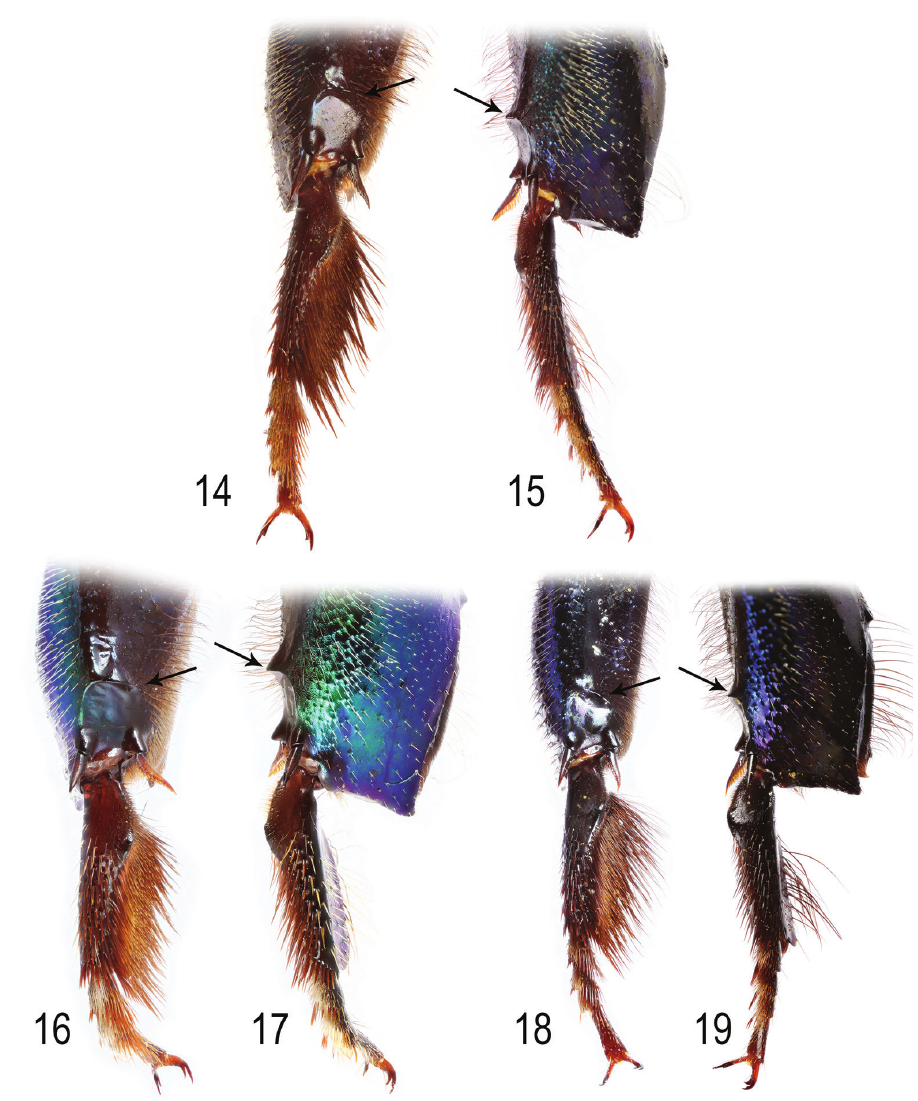
Figures 14–19. Detail of the subapical projection (indicated by an arrow) above the spurs of the male metatibia in anterior ( 14 , 16 , 18 ) and lateral views ( 15, 17, 19 ). 14, 15 E. barthelli (paratype. Mex- ico: Jalisco, Ajijic, KUNHM-ENT 0504535); 16, 17 E. engeli (paratype, KUNHM-ENT 0504531) 18, 19 E. micheneri (paratype. Mexico: Jalisco, Talpa, KUNHM-ENT